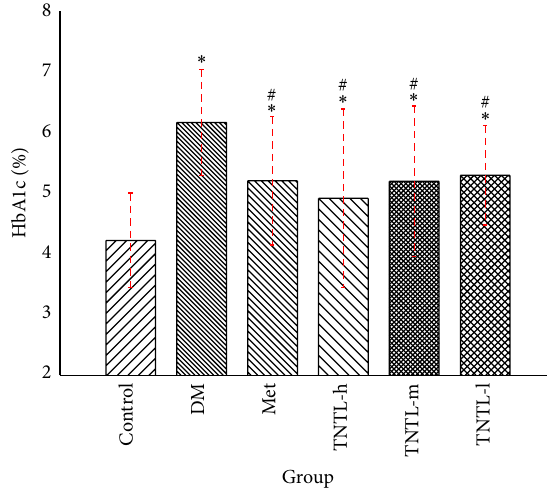
Figure 4: HbA1c levels in db/db mice. HbA1c levels of control (C57BL), DM (db/db mice with untreated), Met (treated with metformin), or TNTL-treated (TNTL-h, m, l = 3.6 g, 1.8 and 0.9g/kg b.w.,resp.)oraladministration. # 𝑃 < 0.05 comparedwithDMgroup. ∗ 𝑃 < 0.05 compared with control group.